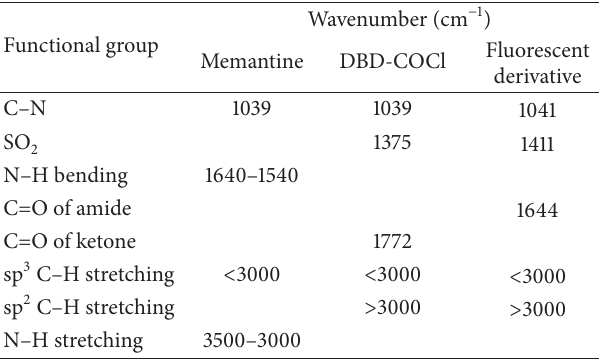
Table 1: Wavenumbers for the functional groups of memantine, DBD-COCl and the fluorescent